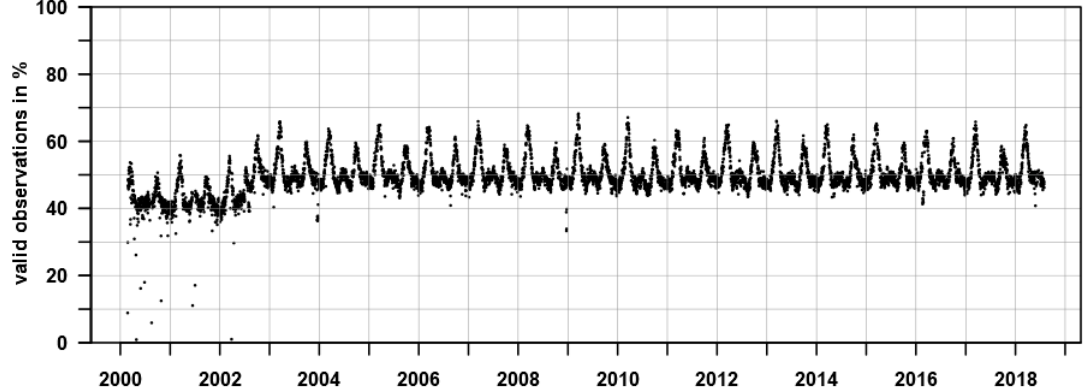
Figure 1. Daily availability of water vapor retrievals. The daily availability shows the percentage of the 13,281 coordinates with valid water vapor